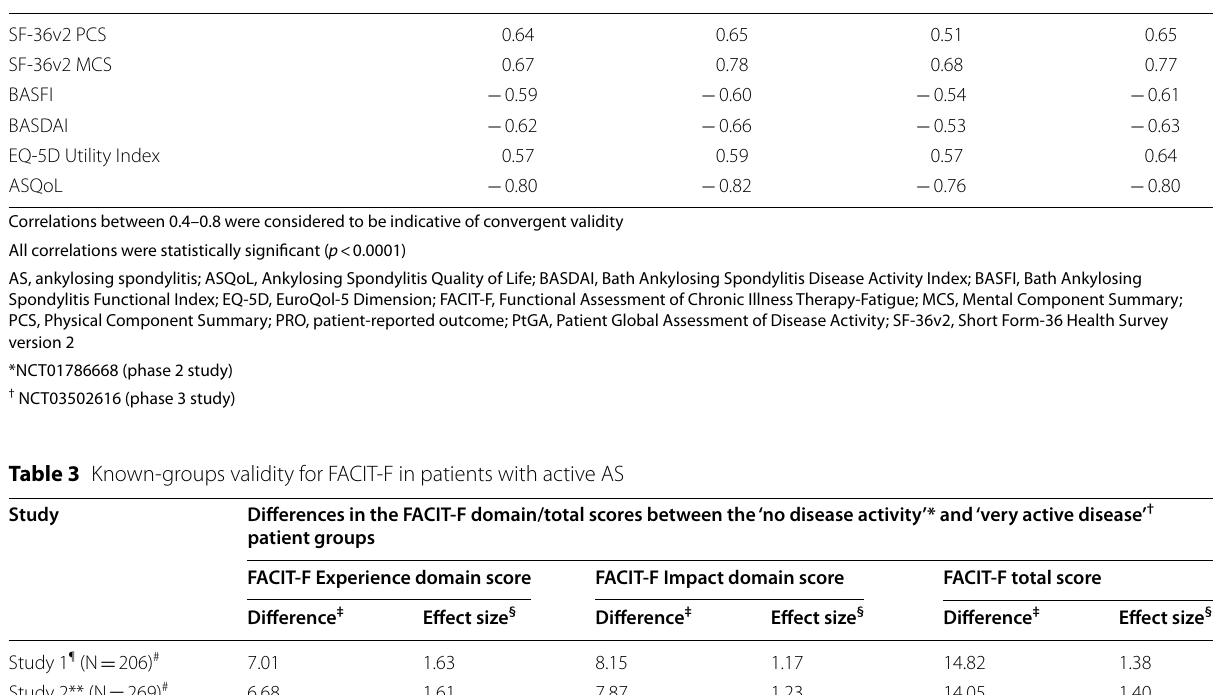
AS, ankylosing spondylitis; FACIT-F, Functional Assessment in Chronic Illness Therapy-Fatigue; PtGA, Patient Global Assessment of Disease